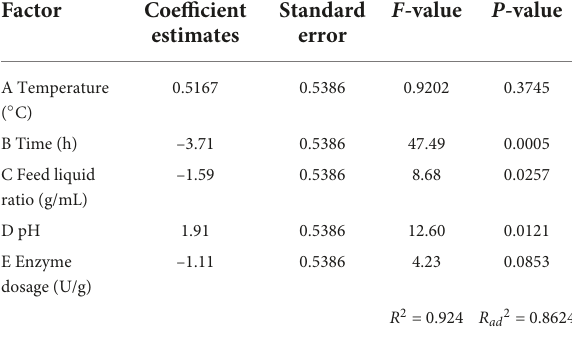
TABLE 2 Coefficient estimates of variables in PB